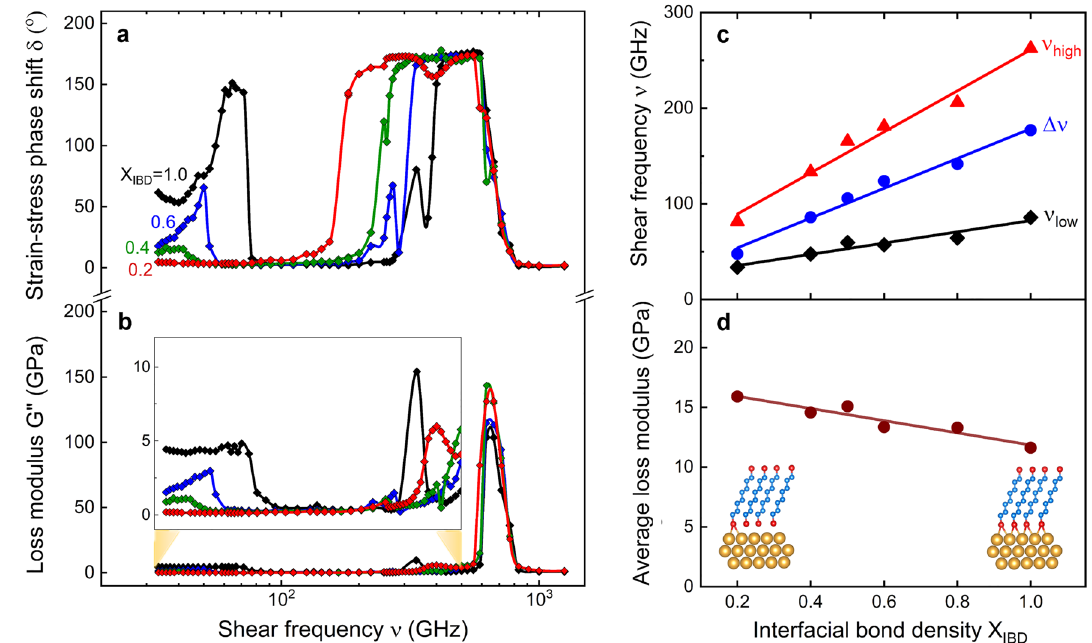
Figure 2. Viscoelastic damping characteristics in Au/octanedithiol MNL/Au multilayers during oscillatory shear for different interfacial Au–S bond densities, X IBD . (a ) Strain–stress phase shift δ and ( b ) loss modulus G’’, as a function of shear frequency. ( c ) Viscoelastic damping gap Δν, and the band edges ν high and ν low , and ( d ) frequency-averaged loss modulus as function of X IBD